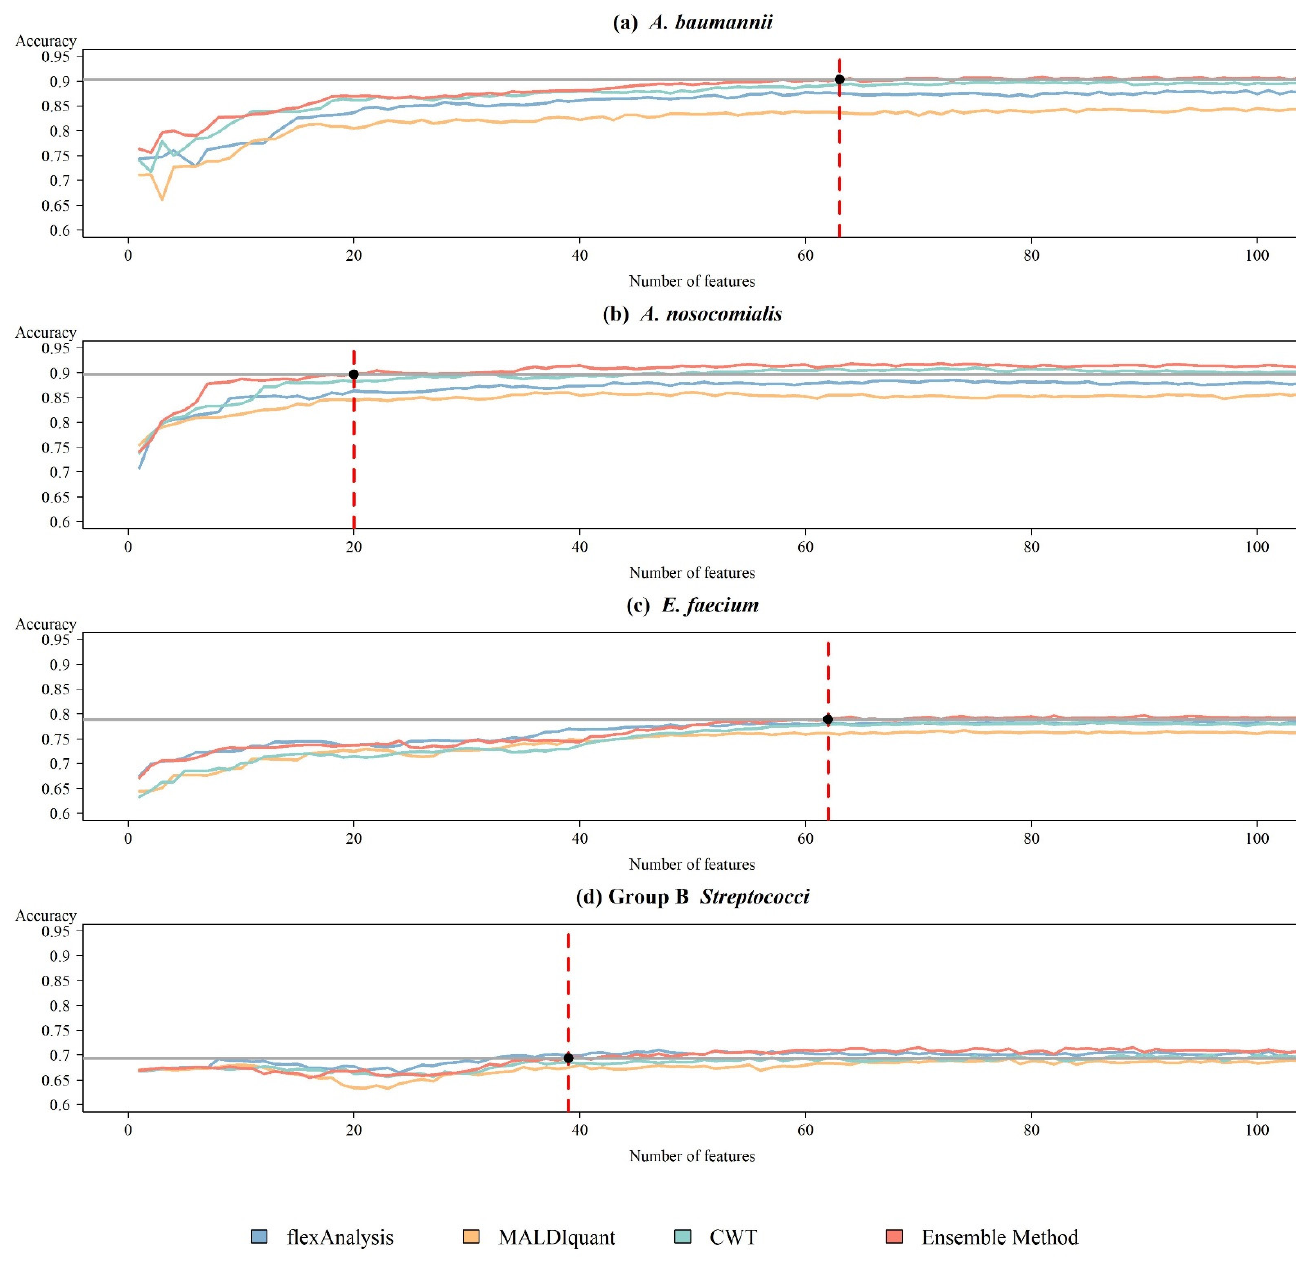
Figure 4. Trend plots of the accuracy using ensemble method preprocessing and RF during the feature selection process on the training datasets for ( a ) A. baumannii , ( b ) A. nosocomialis , ( c ) E. faecium , and ( d ) Group B Streptococci . The red dotted line indicated the number of features that were selected. Table 1. Numbers of features for different preprocessing methods and the corresponding perfor- mance after the feature selection was adopted based on RF.